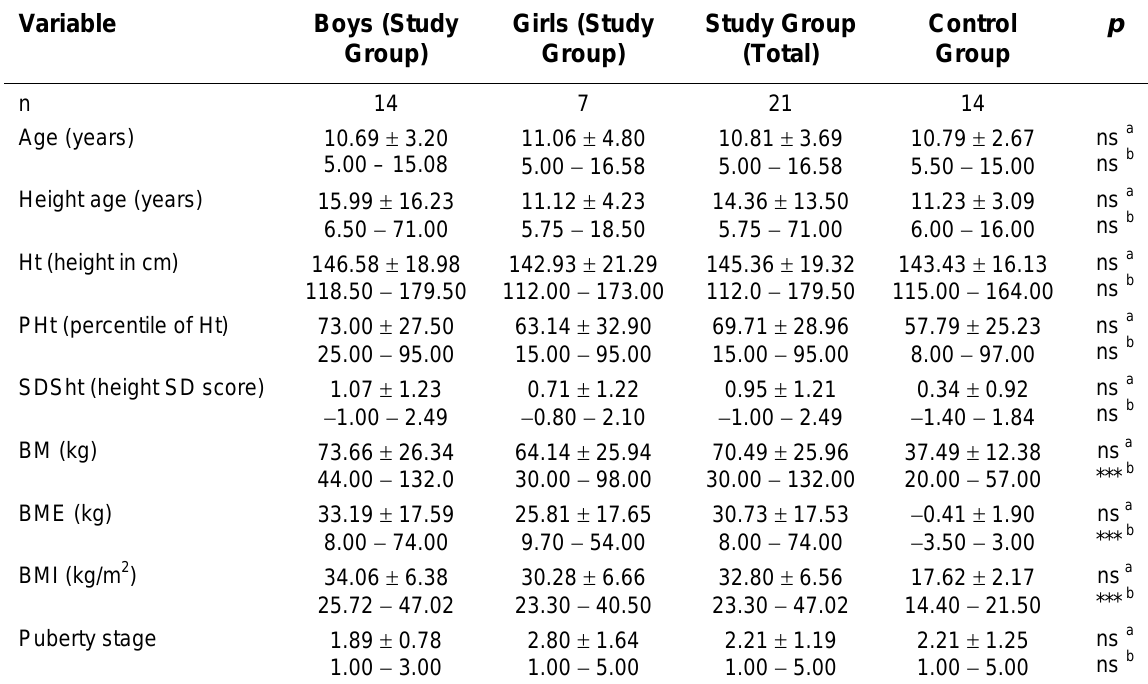
Auxological Data (Mean ± SD,